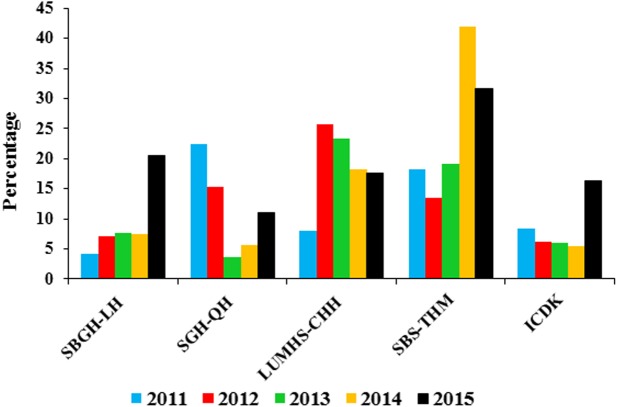
Proportion of childhood TB burden in five hospitals (2011–2015).SBGH-LH, Shah Bhitai Government Hospital, Latifabad, Hyderabad; SGH-QH, Sindh Government Hospital Qasimabad, Hyderabad; LUMHS-CHH, Liaquat University of Medical and Health Sciences Civil Hospital Hyderabad; SBS-THM, Syed Baqadar Shah Taluka Hospital, Matiari; ICDK, Institute of Chest Diseases Kotri, Sindh. The figure shows of childhood TB cases in all five hospitals. The trend varied greatly for all these hospitals during study time. SBGH-LH and ICDK had maximum cases in 2015. For SGH-QH highest cases were noted during 2011, LUMHS-CHH in 2012 and SBS-THM in 2014.